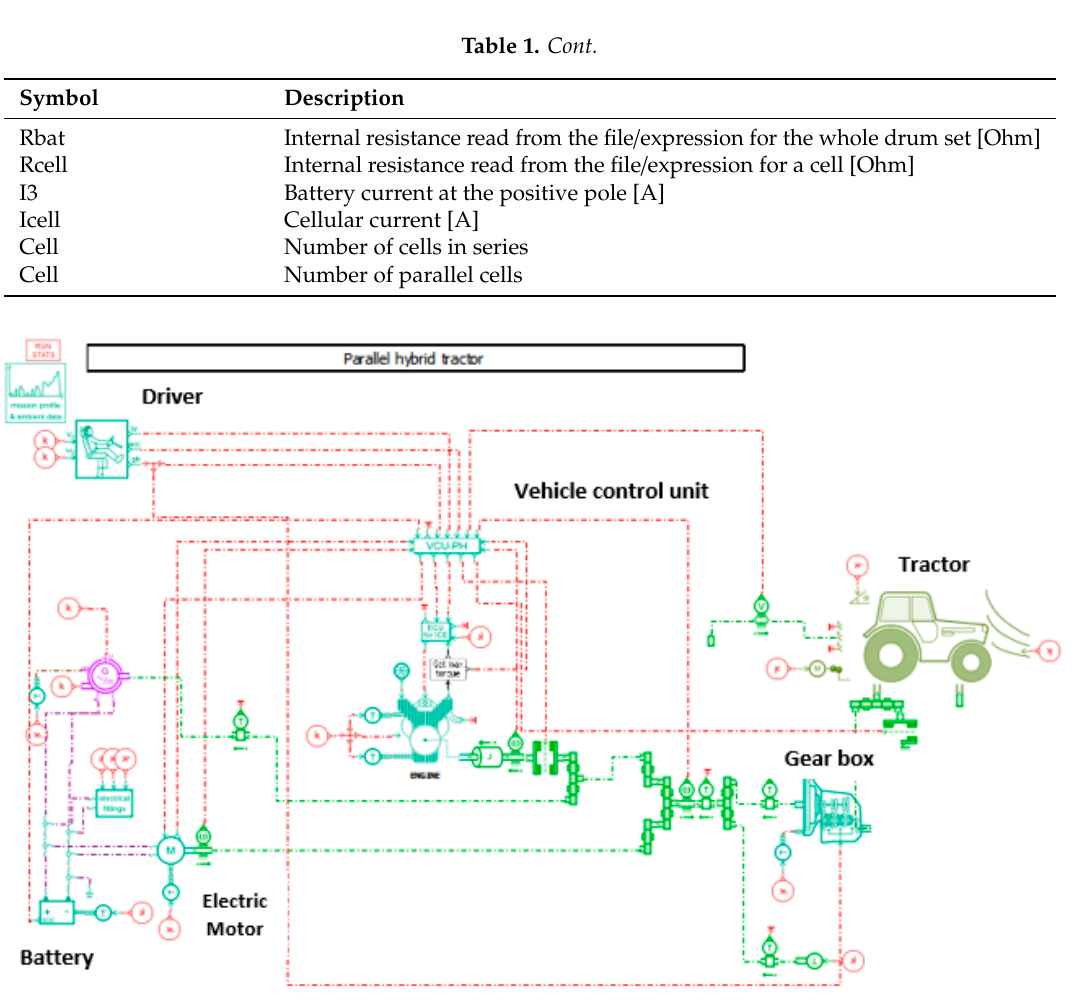
Figure 2. Sketch of the parallel hybrid tractor.